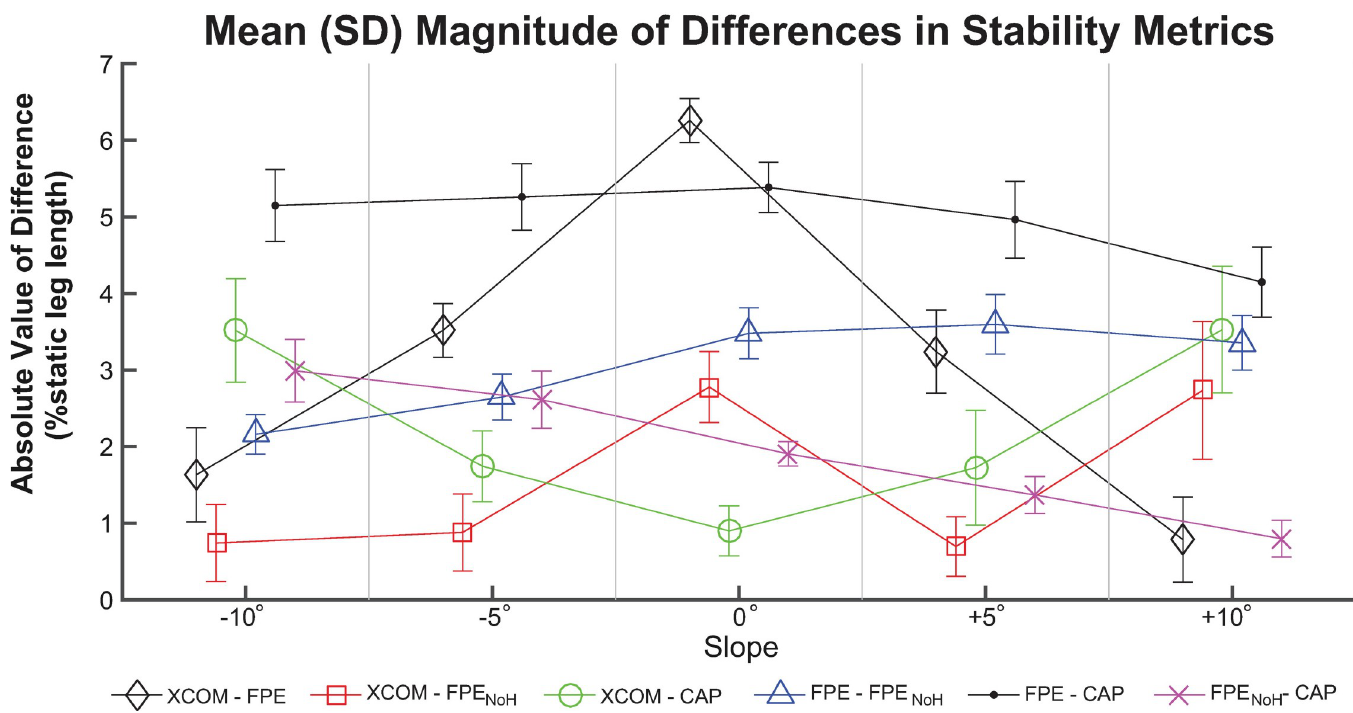
Fig 4. Mean ( ± SD) magnitude of differences between stability metrics. Mean ( ± SD) magnitude (i.e., absolute value) of differences between each pair of stability metrics at each of the slope angles investigated. Comparisons were made between extrapolated center of mass (XCOM), foot placement estimate (FPE), foot placement estimate with no angular momentum (FPE NoH ) and capture point (CAP). Each metric was normalized to percent static (i.e., standing) leg length. Lines connecting data points are solely intended as a visual aid.